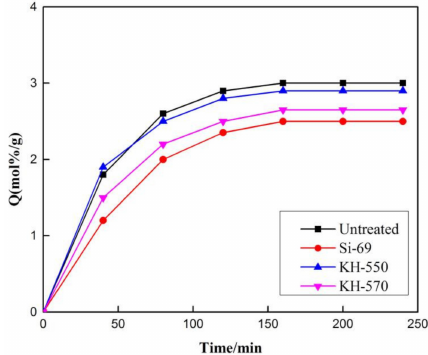
Figure 6. E ff ect of di ff erent silane coupling on swelling properties of vulcanizates.